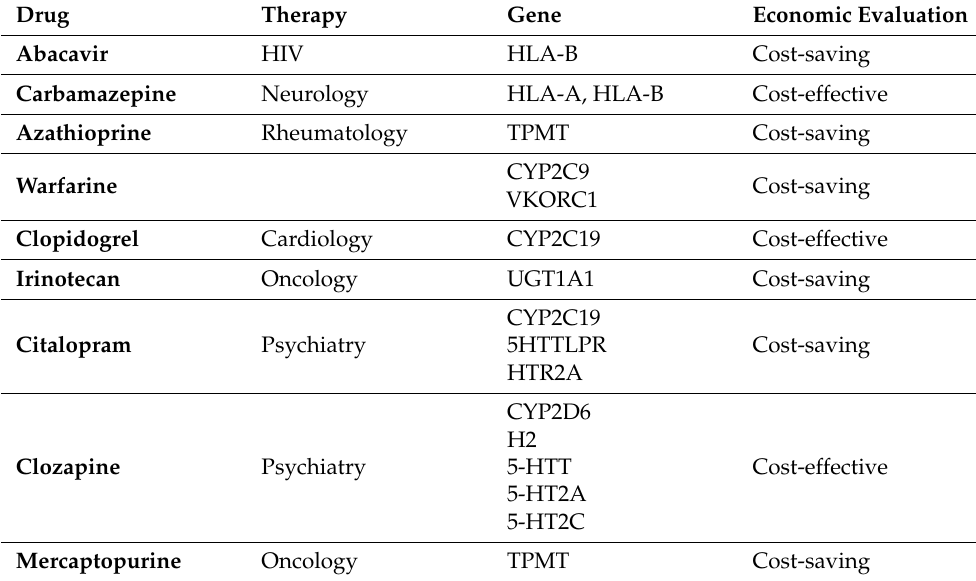
Table 1. Examples of PGx drugs and their economic evaluation.